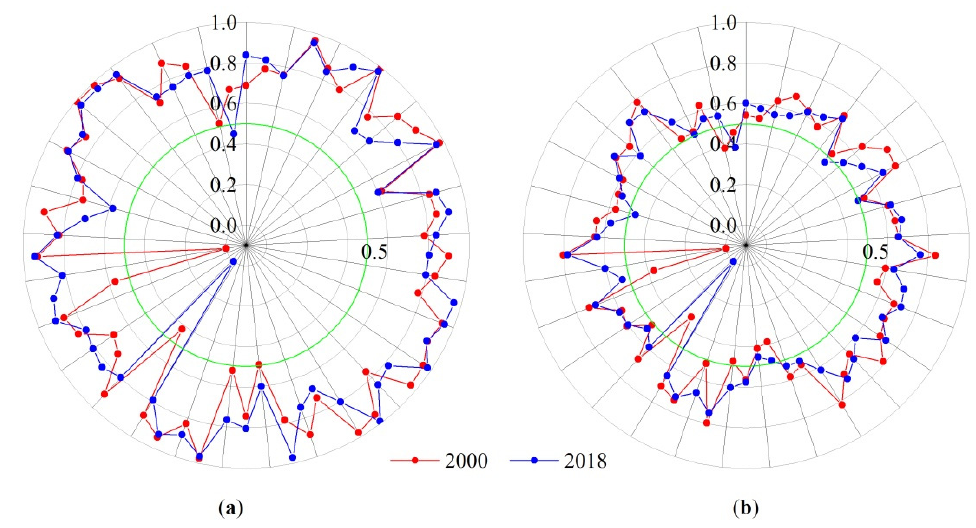
Figure 6. Comparison between coupling and coordination degree of EI and EC and TR in Fujian province in 2000 and 2018. ( a ) Coupling degree of EI & EC &TR; ( b ) Coordination degree of EI & EC &TR.